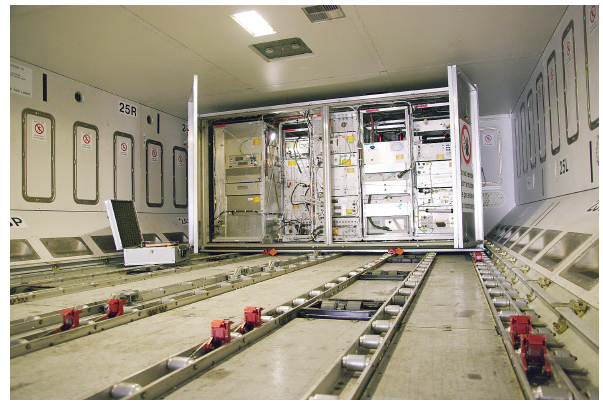
Figure 5. Picture of the CARIBIC laboratory container (1.65t, 19 instruments in 2017) inside the aircraft cargo